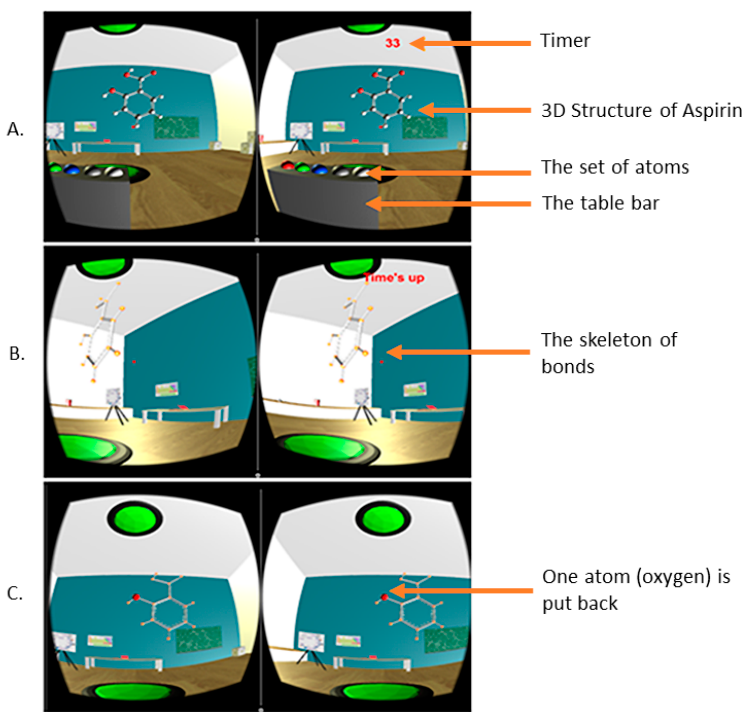
Figure 5. The VR classroom in MedChemVR as seen through a VR Head-Mounted Display (HMD): ( A ) presentation of complete structure for 90 s and relevant items for the completion of the molecule, ( B ) end of the countdown and comparison of the correct model with the student’s version; ( C ) selection of atom position.